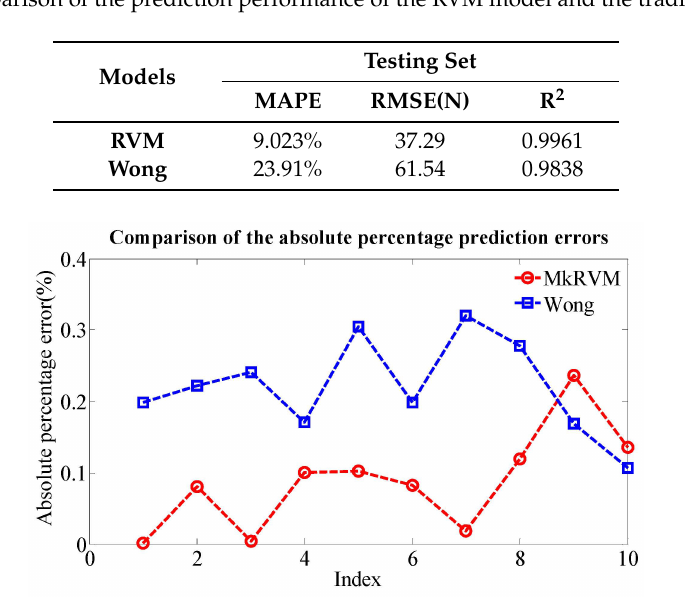
Figure 17. The comparison of the absolute percentage prediction errors between the MkRVM and Wong’s model.